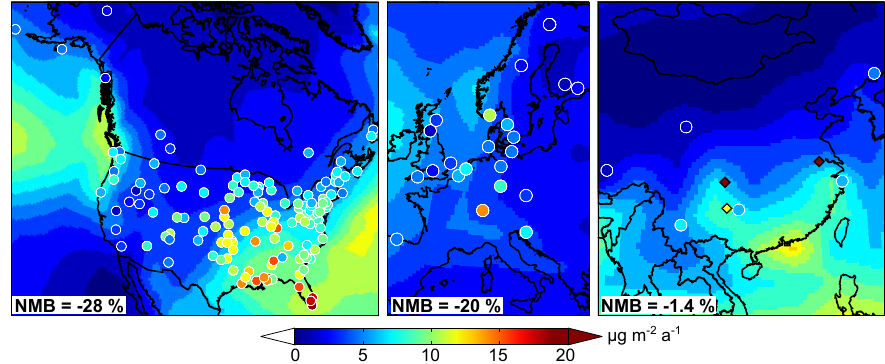
Figure 6. Annual Hg wet deposition fluxes over North America, Europe, and China. Model values for 2009–2011 (background contours) are compared to 2007–2013 observations from the Mercury Deposition Network (MDN, National Atmospheric Deposition Program, http://nadp. sws.uiuc.edu/mdn/) over North America (58 sites), the European Monitoring and Evaluation Programme (EMEP) over Europe (20 sites), and data from Fu et al. (2015, 2016) over China (9 sites). In the China panel, circles represent rural sites, and diamonds represent urban sites as identified in Fu et al. (2015, 2016). For the MDN and EMEP networks, which collect weekly or monthly integrated samples, we only include sites with at least 75% of annual data for at least 1 year between 2007 and 2013; for China we only include sites with at least 9 months of data over the 2007–2013 period. MDN data are formally quality-controlled, while for EMEP data we rely on a subset of sites that have been quality-controlled (O. Travnikov, personal communication, 2016). Legends give the normalized mean bias (NMB) for all sites, excluding urban sites in China.